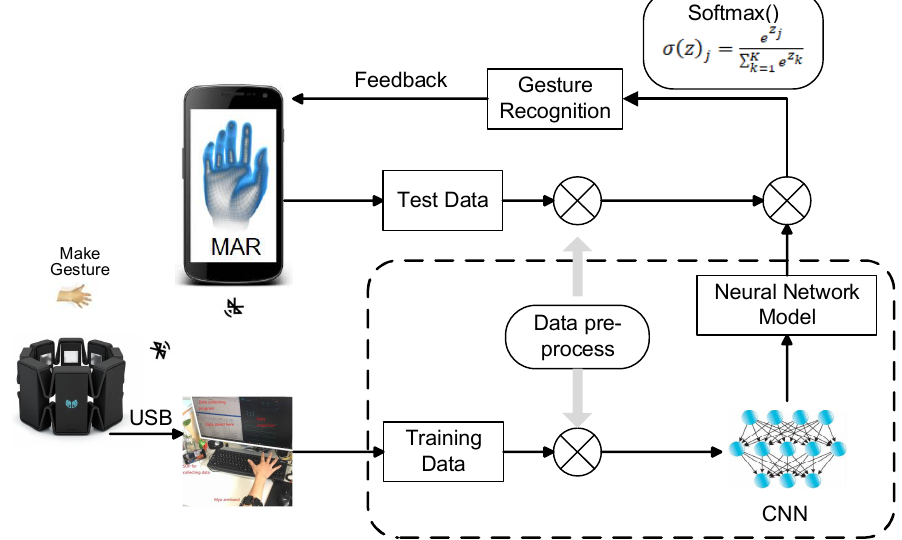
Figure 1. The diagram of the mirror therapy system based on mobile augmented reality (MAR).